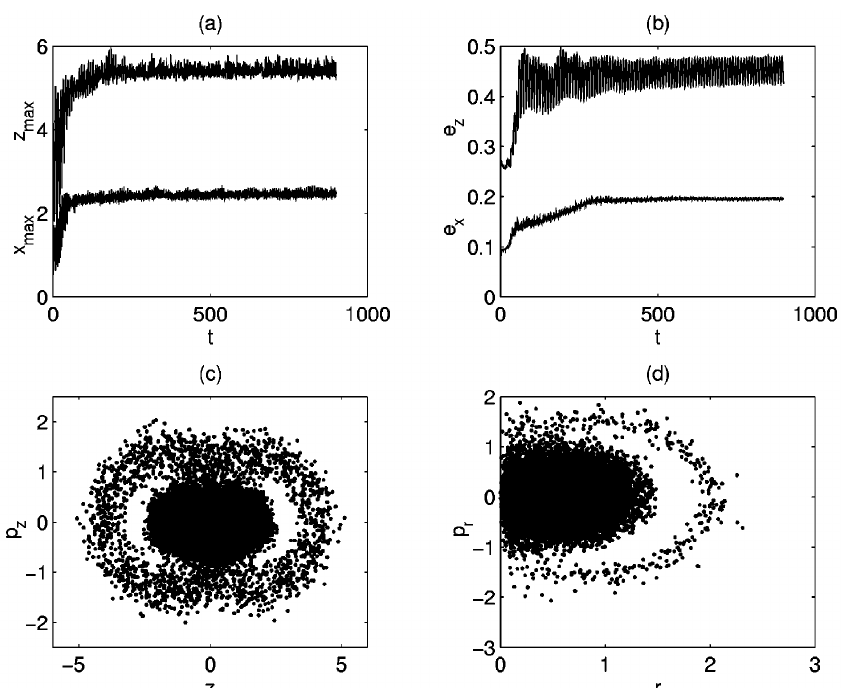
FIG. 12. 6D uniform distribution m (cid:120) (cid:173) m (cid:121) (cid:173) m (cid:122) (cid:173) (cid:49)(cid:46)(cid:53) ( (cid:99) (cid:121) (cid:97) (cid:173) (cid:51)(cid:44) h (cid:120) (cid:173) (cid:48)(cid:46)(cid:53)(cid:51)(cid:44) h (cid:122) (cid:173) (cid:48)(cid:46)(cid:51)(cid:57) ): (a) maximum (cid:120) and (cid:122) , (b) emittance growth, (c) (cid:122) (cid:45) (cid:112) (cid:122) diagram at (cid:116) (cid:173) (cid:57)(cid:48)(cid:48) (with 32 768 particles plotted), and (d) (cid:114) (cid:45) (cid:112) (cid:114) diagram at (cid:116) (cid:173) (cid:57)(cid:48)(cid:48) for particles with the angular momentum j (cid:76) (cid:122) j , (cid:48)(cid:46)(cid:49) (with 25 000 particles plotted).